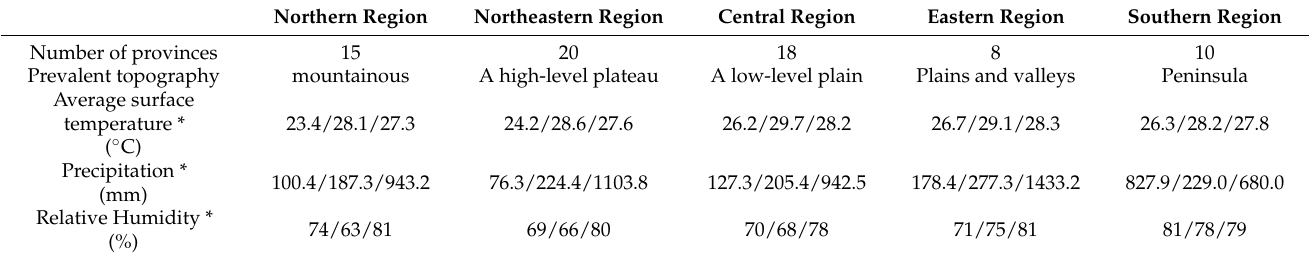
Table 1. Climatic and physical characteristics of climatic